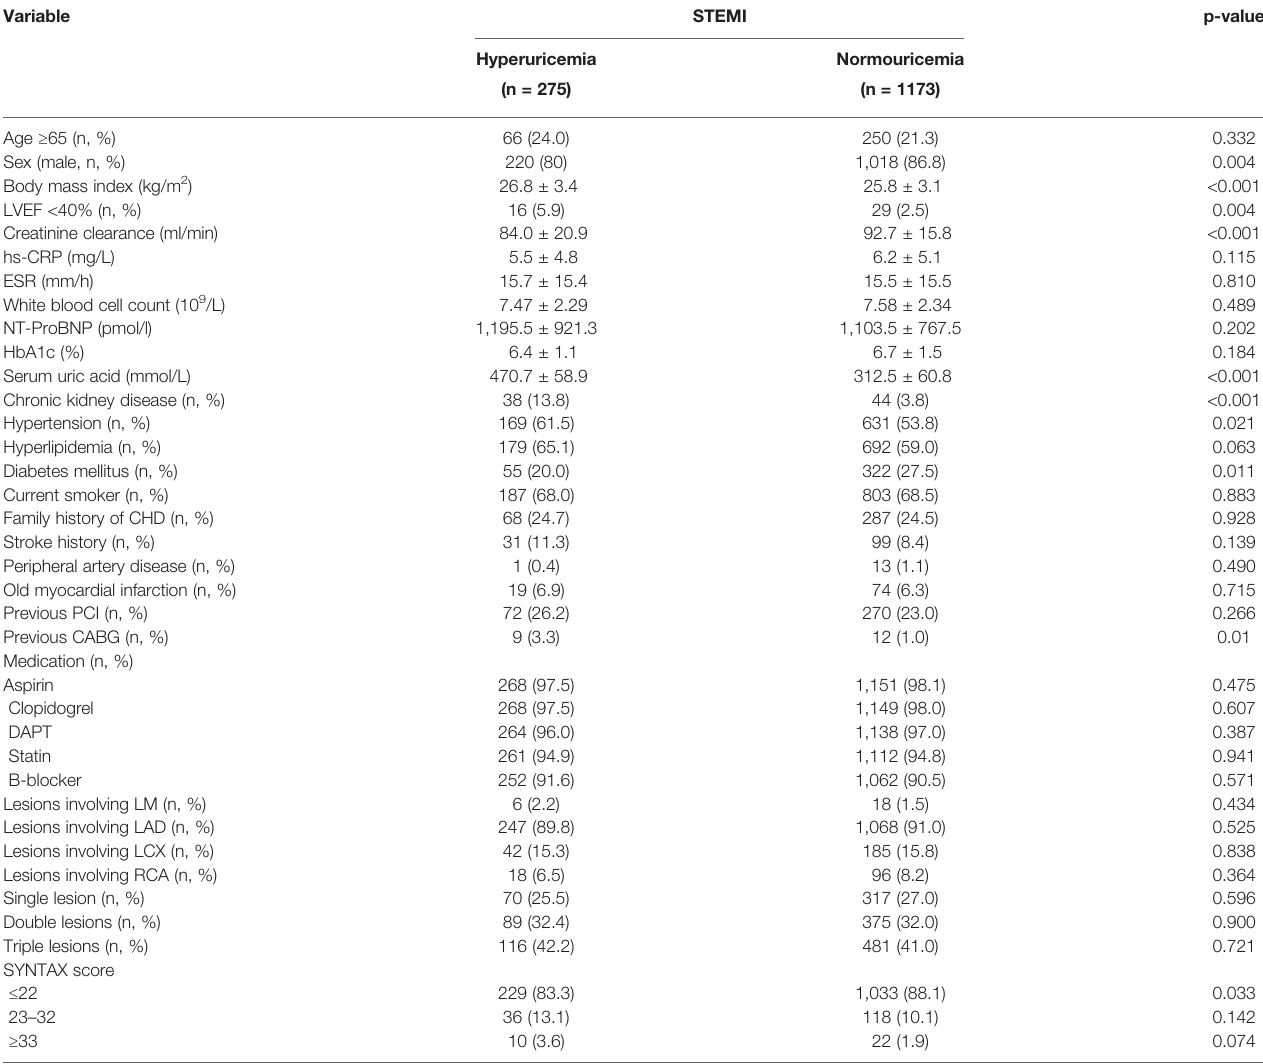
TABLE 1 | Baseline characteristics of the study